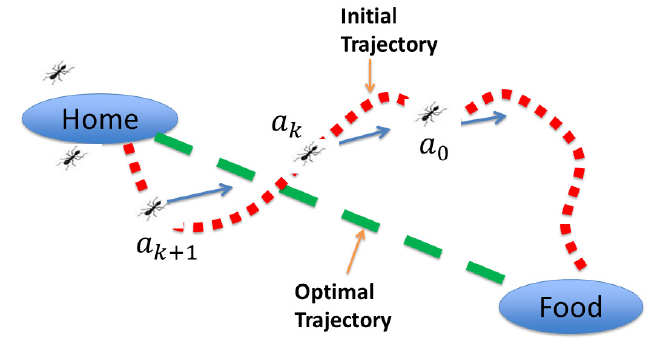
Figure 2. Schematic representation of the ant’s rule of pursuit.